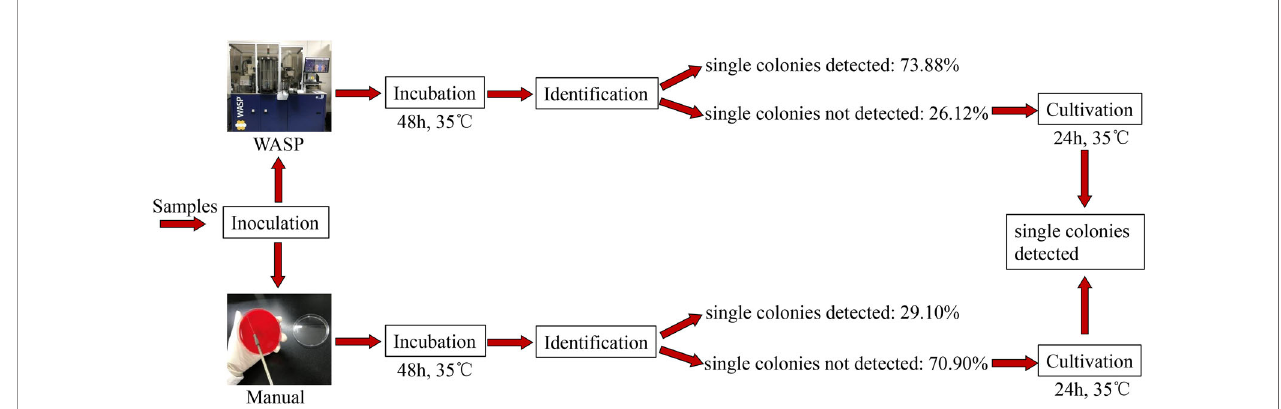
FIGURE 2 | Difference in detection rate of single colonies between Copan wasp and manual method: For 402 samples we detected, 73.88% of them could directly incubate single colonies for identi fi cation within 48 hours by using Copan WASP, but this rate was only 29.10% if using manual method. It demonstrated that the